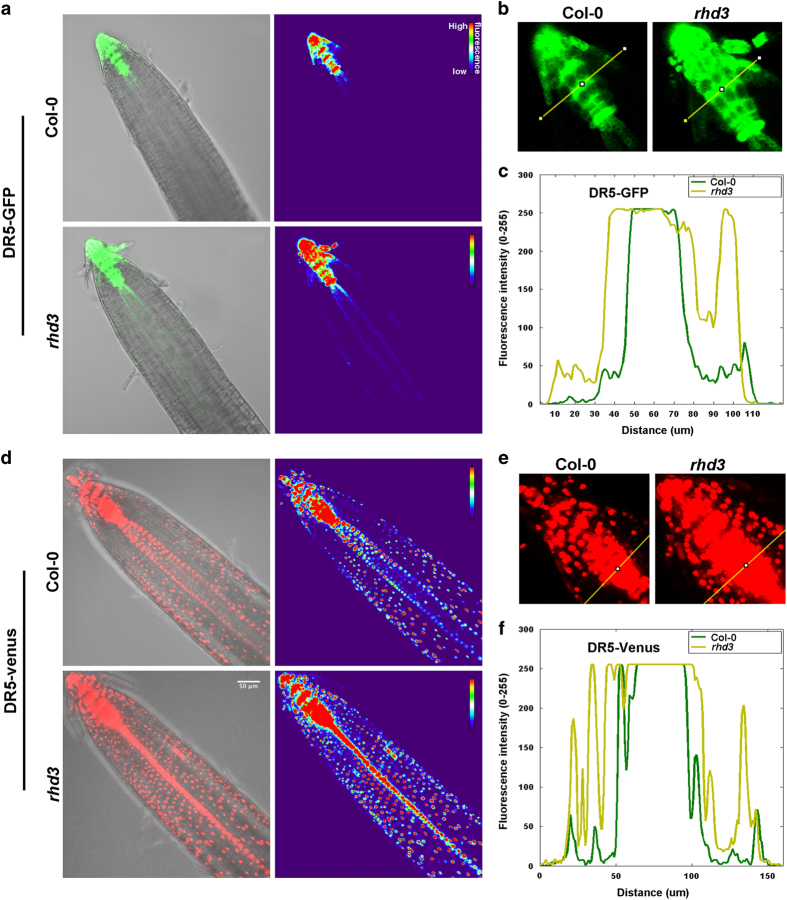
Auxin abundance. (a, d) Representative confocal image of DR5-GFP and DR5-VENUS (GFP or VENUS driven by the synthetic auxin-response promoter DR5 that reflects relative auxin levels) roots (7DAG) in wild type (Col-0) and rhd3 showing an enlarged area with levels of auxin in the longitudinal axis rhd3 roots compared with wild type. (b) Confocal image of DR5-GFP root at the apex and (c) quantification of the fluorescence in the graph. (e) Confocal image of DR5-Venus root at the apex and (f) quantification of the fluorescence in the graph. The images displayed are representative of at least three independent experiments with >10 seedlings examined each experiment. Scale bar, 50 μm.